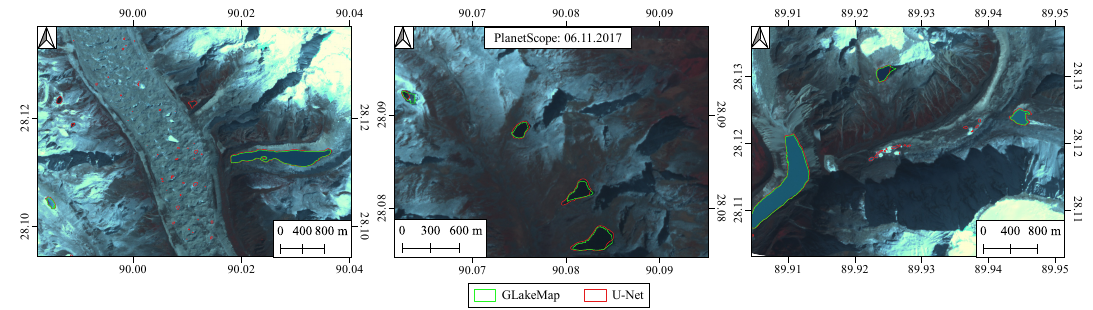
Figure 13. Comparison of the outlines from U-Net and GLakeMap [56]. The PlanetScope data and Sentinel-2 data used here are from 06.11.2017. This location is part of the labeled dataset shown in Figure 2. However, the date of the PlanetScope imagery was different in the data shown in Figure